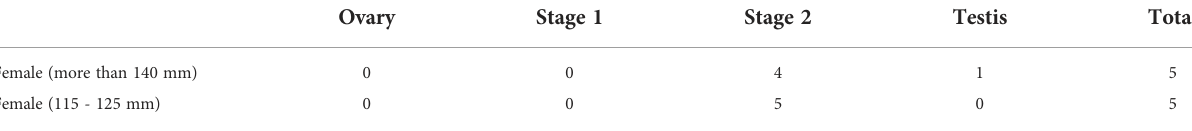
TABLE 3 Gonadal stages of large and small IP fi sh kept with fi ve smaller